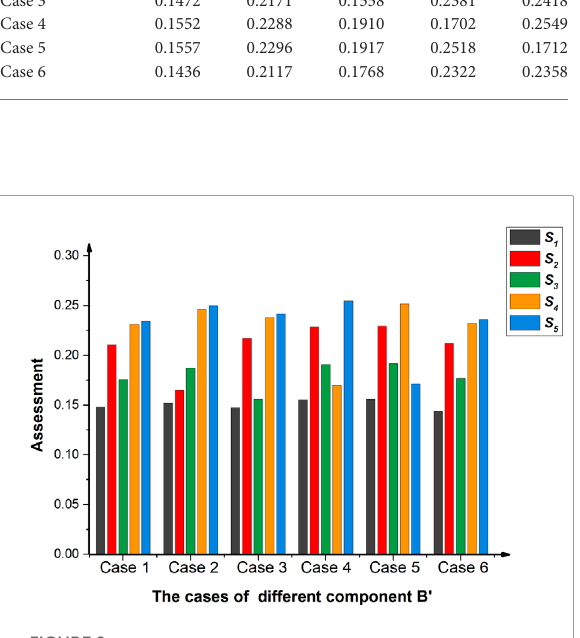
FIGURE 9 Histogram of the assessment results under six cases of different defuzzified component B ′